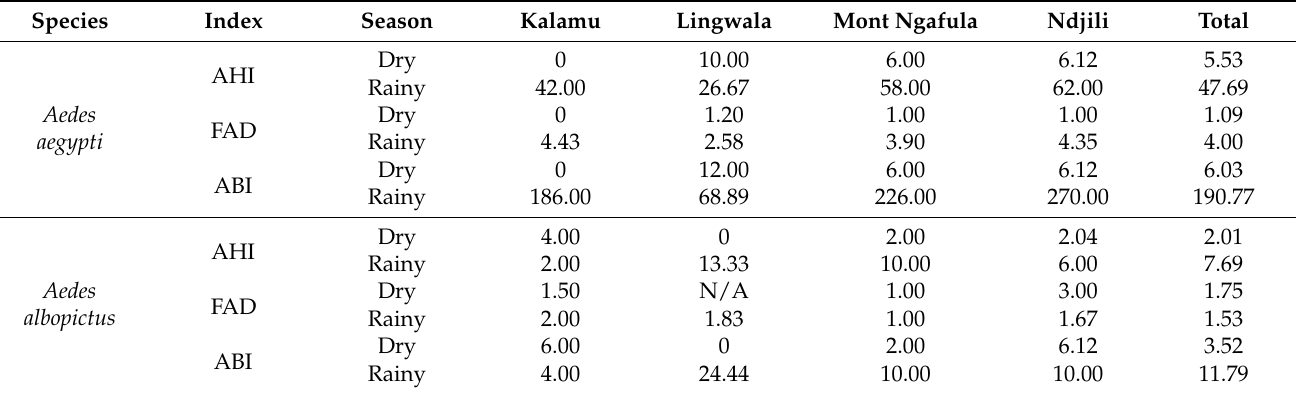
Table 4. Female Aedes mosquito indices per species and season (combined indoor and outdoor collections) in the four study sites in Kinshasa. (Dry season = July 2019 and rainy season = February 2020). Indices were based on the prokopack collections (50